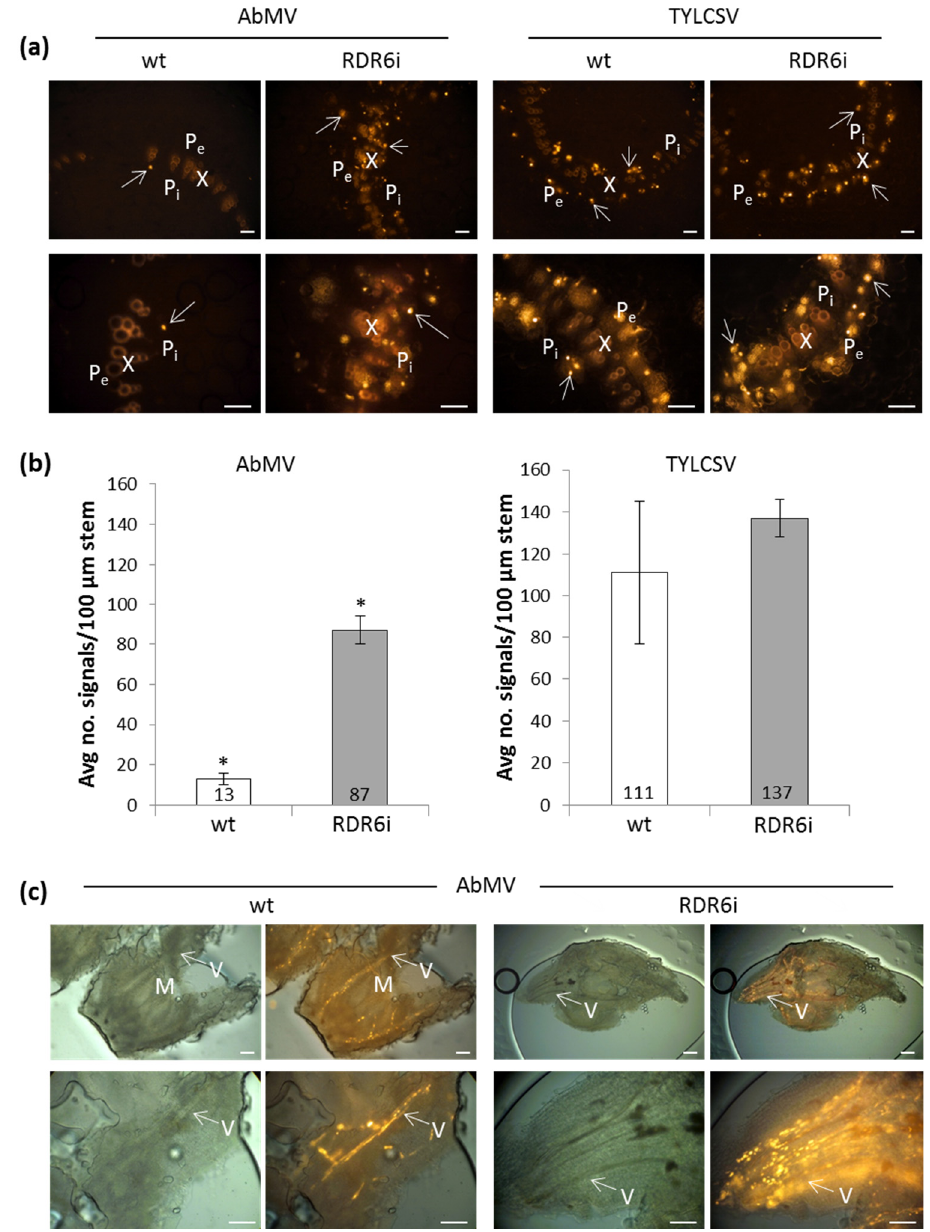
Figure 3. Localization of AbMV or TYLCSV DNA in leaves of wild-type (wt) and RDR6i plants. ( a ) FISH analysis of stem cross sections (100 µm thick) fi xed at 49 dpi; virus detection using fl uorescently labelled AbMV- or TYLCSV-speci fi c oligonucleotide probes. Arrows point at signals representing exemplary virus-infected nuclei inside the two (internal and external) phloem domains adjacent to the auto- fl uorescent xylem elements. X: xylem, P i/e : phloem (internal/external), scale bars: 100 µm. ( b ) Average numbers of virus-infected nuclei in 100 µm thick stem sections of similar diameters were measured in plants infected by either AbMV or TYLCSV. Data represent 673 signals for AbMV (six or eight sections per plant genotype), and 1154 signals for TYLCSV (three or six sections, respectively). Asterisks indicate signi fi cant di ff erences, as indicated above. ( c ) AbMV DNA in vascular tissues around the apical meristem (for wt plants) or flower bud (for RDR6i plants) of whole-mount specimens. M: meristem, V: vascular bundle (exemplary labels), scale bars: 100 µ